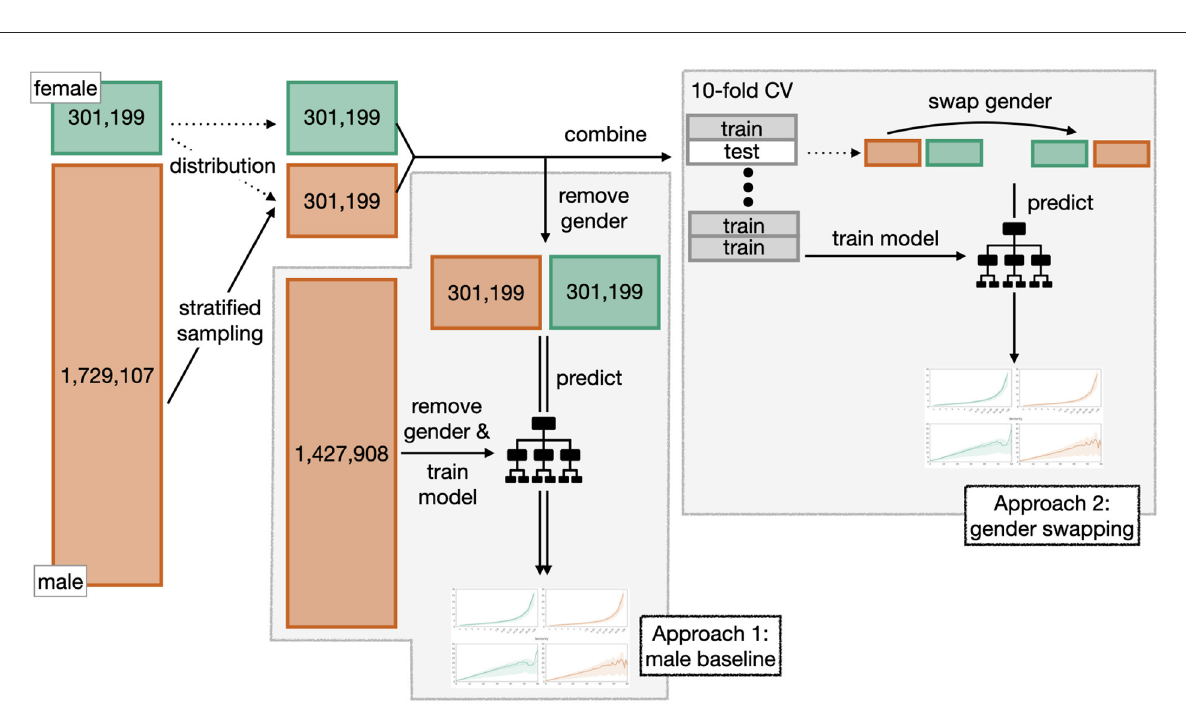
balanced in terms of gender by using the stratification described above to sample an equal amount of male records. This yields a dataset of ∼ 600,000 records. Within a 10-fold cross-validation we train models and compute scores on test sets. In each